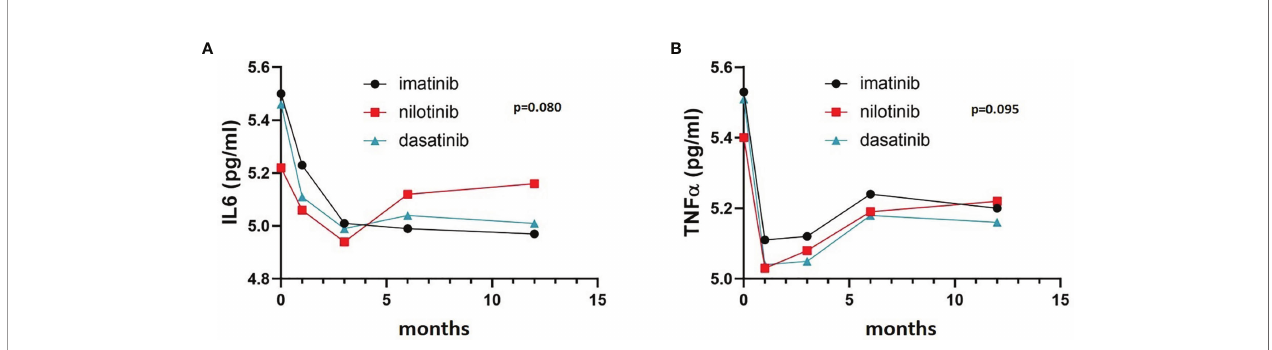
FIGURE 1 | IL6 and TNF a trends in the three cohorts. Three-way ANOVA. IL6 (A) and TNF a (B) levels were high at diagnosis and decreased during the fi rst 12 months of treatment, without any statistically signi fi cant difference between the three treatment arms (F= 2.190, p= 0.095 and F= 2.380 p= 0.080 respectively).